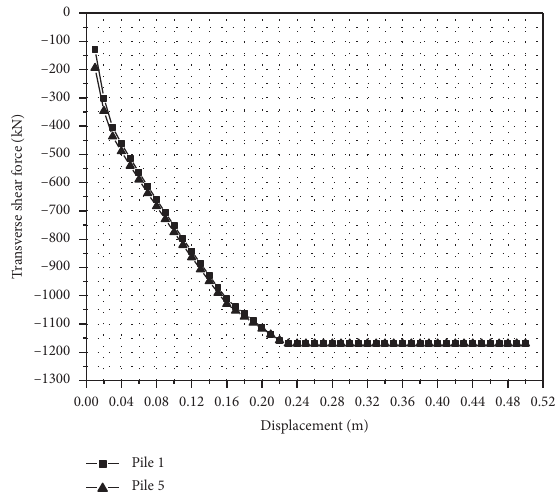
Figure 36: Transverse shear force-displacement at the top of typical piles.